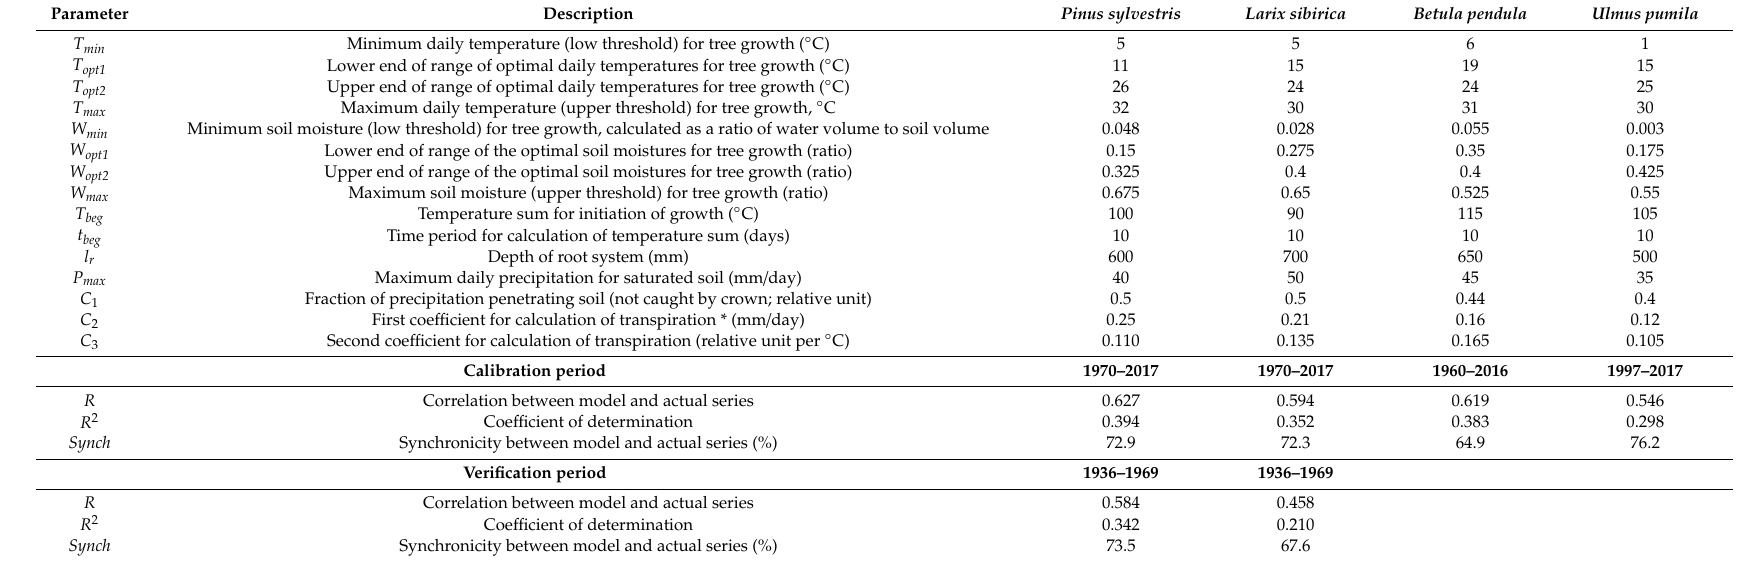
Table 3. Optimal parameters and statistics of the tree growth imitation VS-model for the four species.